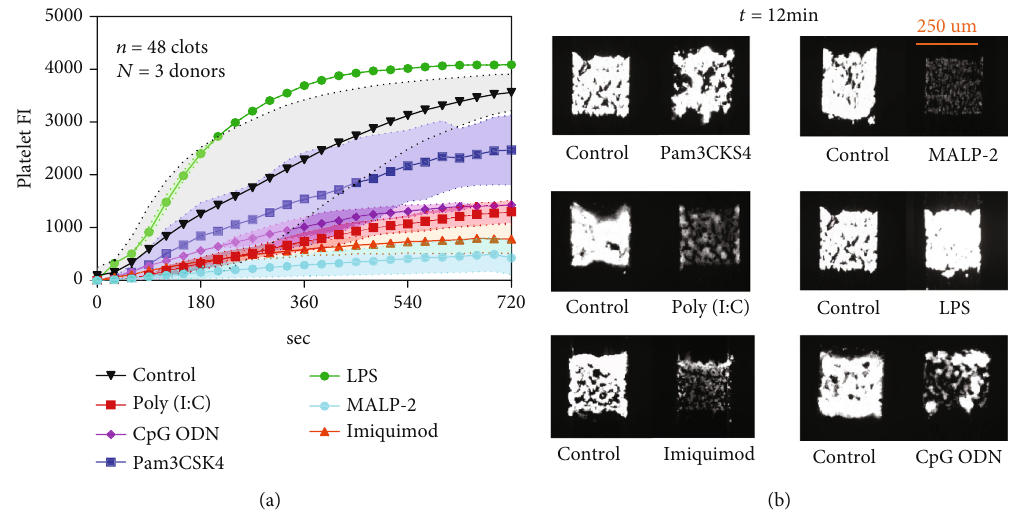
Figure 2: TLR ligands (except LPS) inhibit platelet deposition onto collagen under fl ow. PPACK WB treated with HBS (control) or TLR ligands was perfused over collagen at 100 s -1 for 720 seconds. CD61 was added to all channels to label platelets. Platelet FI was measured throughout the course of the experiments (a) and Figure 2(b) shows how they looked under the microscope at the end point.